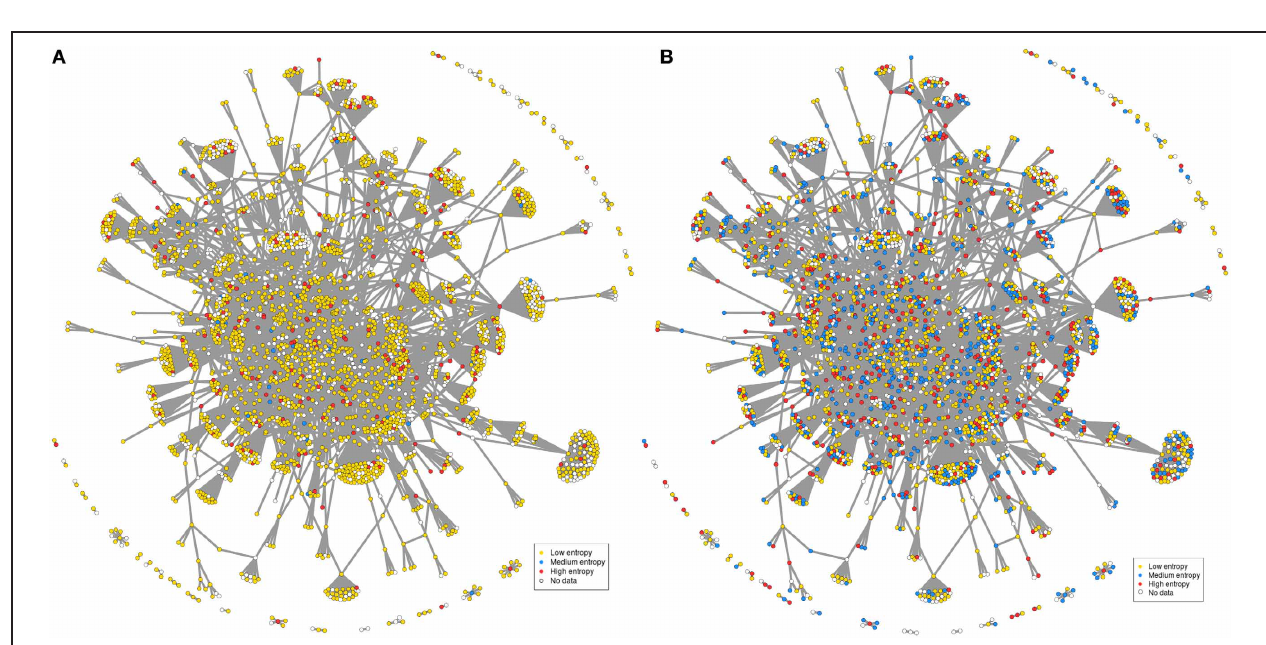
corresponding to low, middle, and high entropy values. Details of the full heat-maps can be visualized in Figures S3–5 . The color code indicates − log P -values. Gene contents are shown in Tables S6–8 .